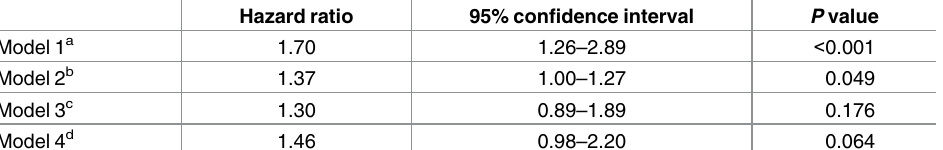
Table 2. Multivariate risk factor analysis of the mortality of elderly patients with end-stage renal dis- ease in the early dialysis group compared to the late dialysis group using Cox regression models and a propensity score matched